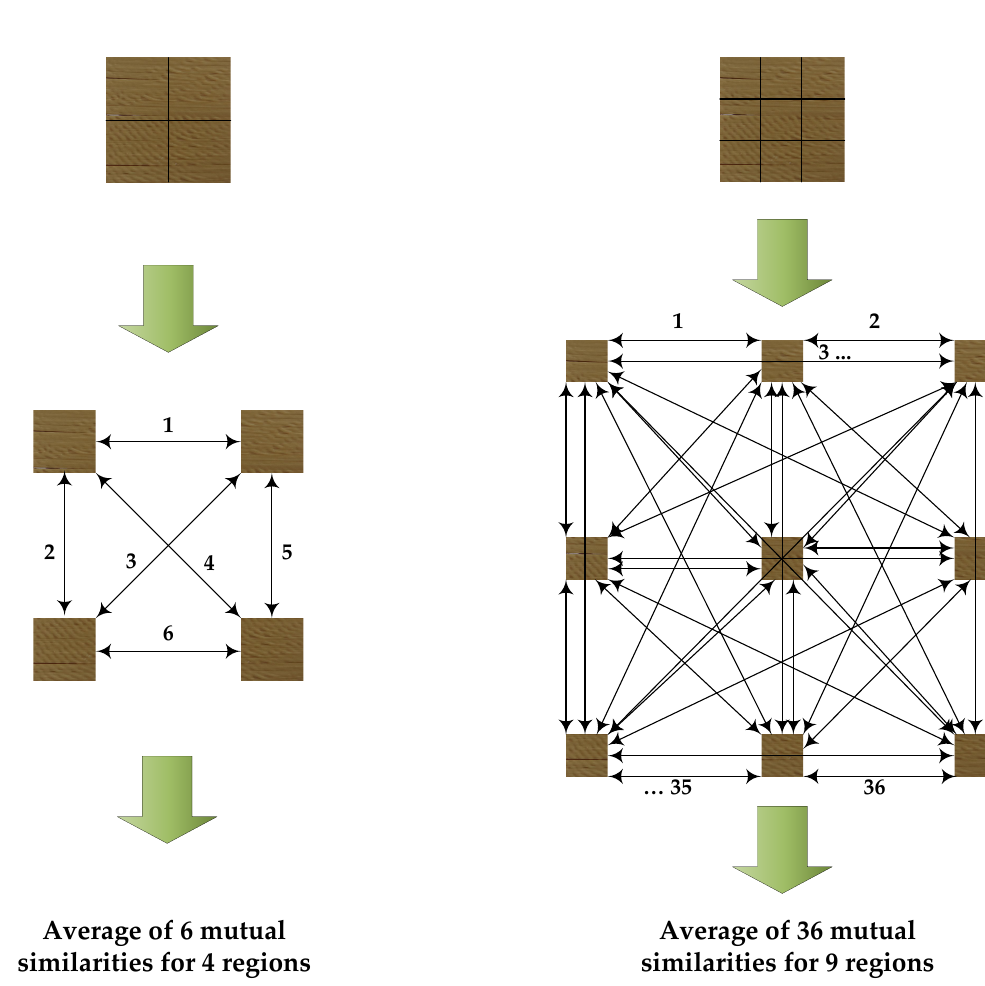
Figure 2. Illustration of the idea of mutual similarity calculation for the division into 4 and 9 regions with necessary respective 6 and 36 computations of the FR